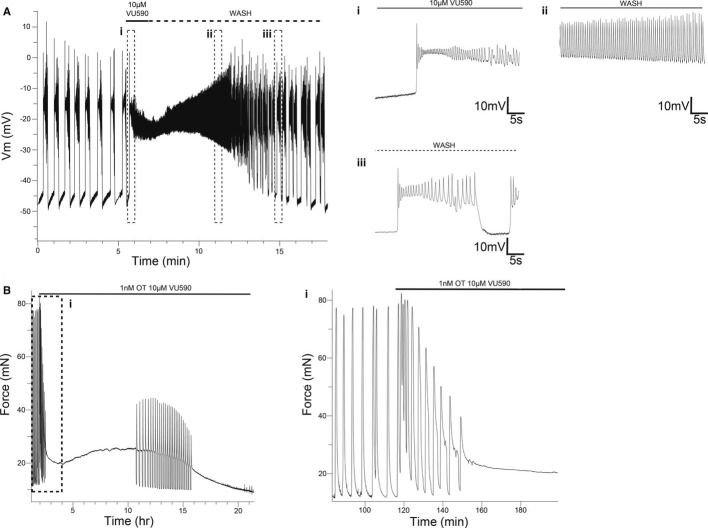
Pharmacological inhibition of Kir7.1 in vitro in human and murine myometrium induces membrane depolarization and long-lasting contractionsRepresentative membrane potential recording in current clamp configuration from a murine GD15 myometrial strip. (i) Addition of 10 μM VU590 depolarizes resting membrane potential (note slope change from resting potentials of preceding phasic bursts) and leads to a sustained plateau potential. (ii) Upon washout, spike potentials recover as plateau potential hyperpolarizes. (iii) On complete washout, phasic bursting resumes.Addition of 1 nM oxytocin and 10 μM VU590 to human myometrial strips stimulates long-lasting contractions. (i) Initial component of the response is phasic, followed by establishment of a tonic contraction.